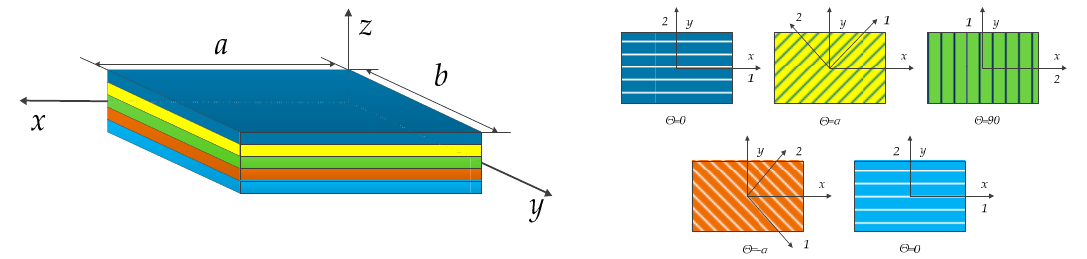
Figure 1. Abbreviated drawing of laminated composite plates.